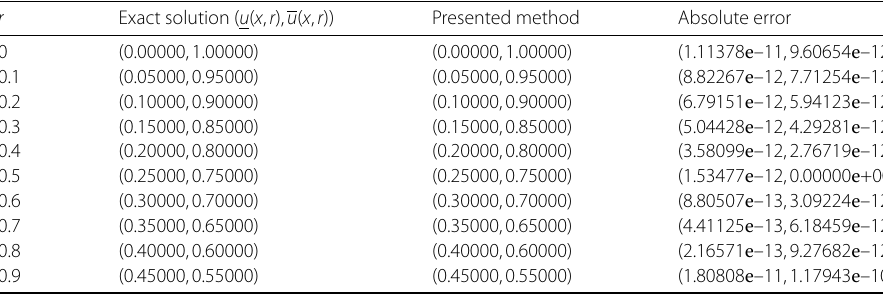
Table 3 The numerical results for Example 3 with x = 0.5, M = 2, N = 3